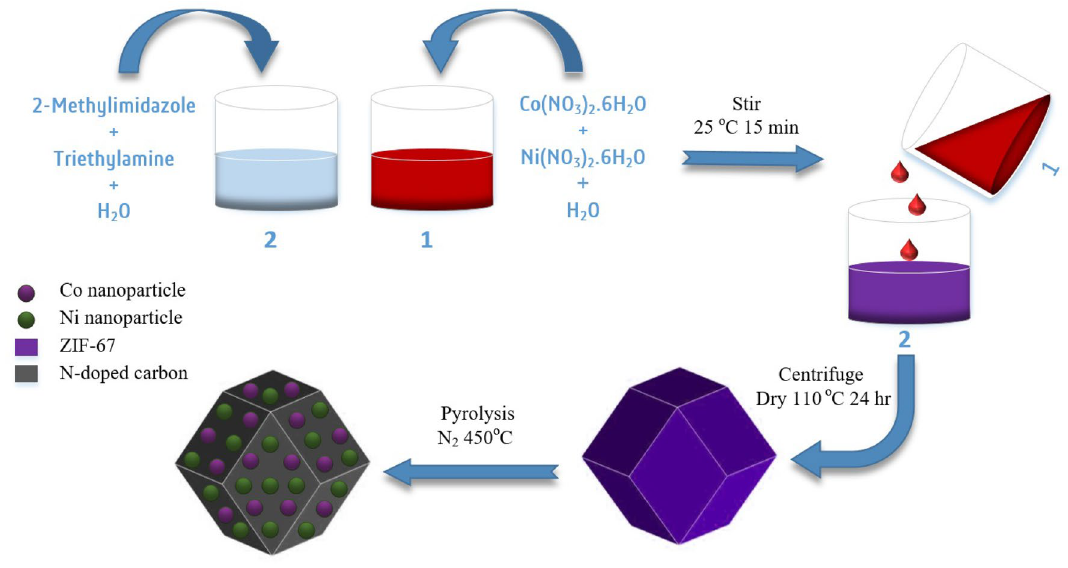
Figure 1. Schematic illustration of NiCo/NC catalyst